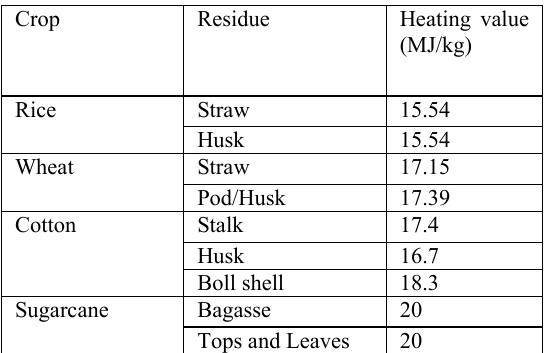
Table: 3.2 Heating values (Calorific values) of different crop residues